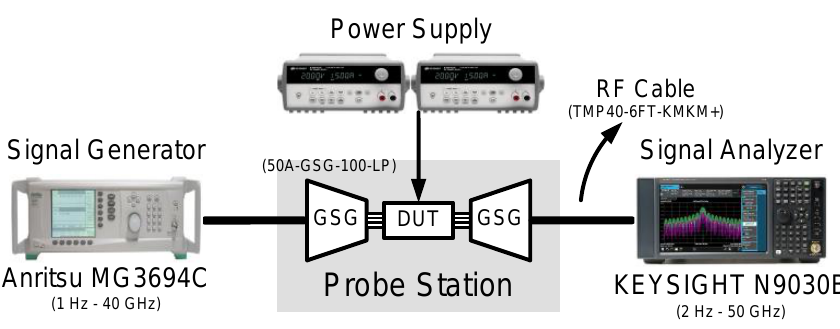
Figure 11. Measurement setup for the proposed CR-ILFD.